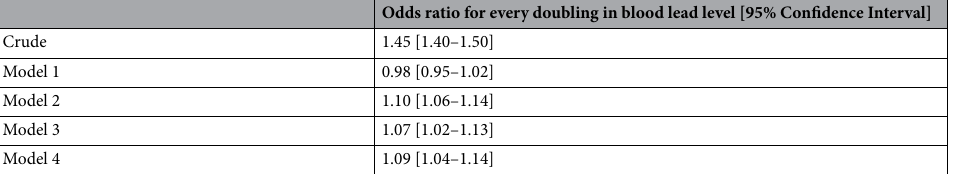
Table 3. Association between blood lead level and hypertension. Figures are expressed as odds ratio [95% confidence interval]. Model 1: adjusted for age, gender and ethnicity. Model 2: adjusted for age, gender, ethnicity and waist circumference. Model 3: adjusted for age, gender, ethnicity, waist circumference, poverty to income ratio, education and ever cigarette smoking. Model 4: adjusted for age, gender, ethnicity, waist circumference, poverty to income ratio, education, ever cigarette smoking, diabetes and stage 3–5 chronic kidney diseases.